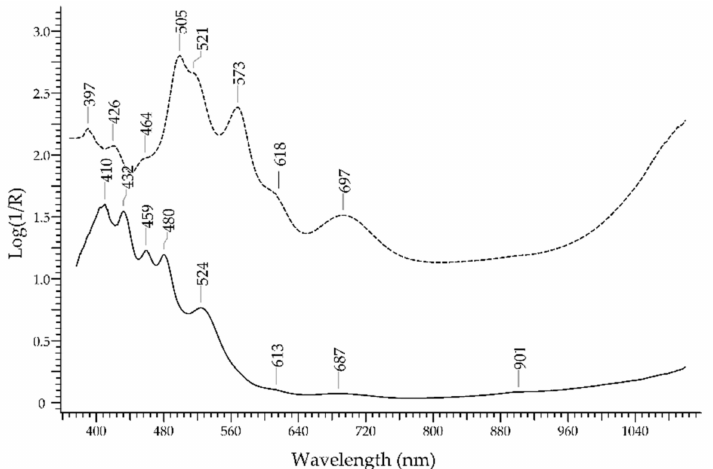
Figure 12. FORS spectrum in Log(1/R) coordinates of a spessartite garnet (solid line) and a purple pyrope–almandine garnet (dashed line).